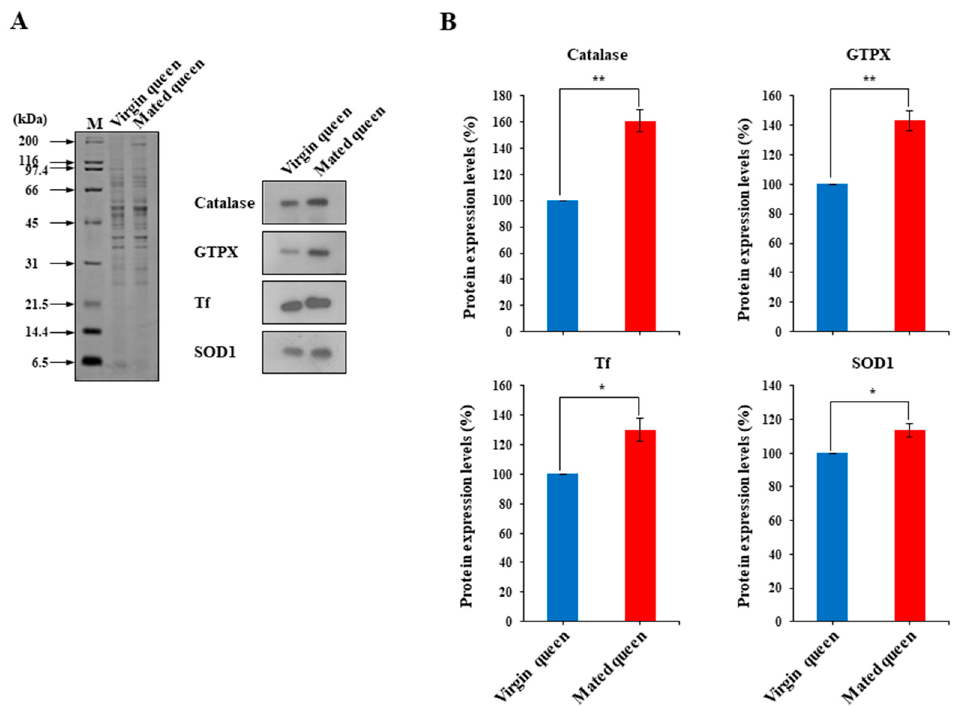
Figure 3. Detection of antioxidant proteins in the spermathecal fluid of virgin and mated queens. ( A ) Antioxidant proteins (catalase, GTPX, Tf, or SOD1) in the spermathecal fluid of virgin and mated queens were detected using SDS-PAGE (Left), and Western blot analysis was conducted using antibodies against catalase, GTPX, Tf, or SOD1 (Right). ( B ) The levels of catalase, GTPX, Tf, and SOD1 proteins are shown relative to their levels in the spermathecal fluid of virgin queens (shown as 100%). The bars represent the mean ± SD values. * p < 0.05 and ** p < 0.01.